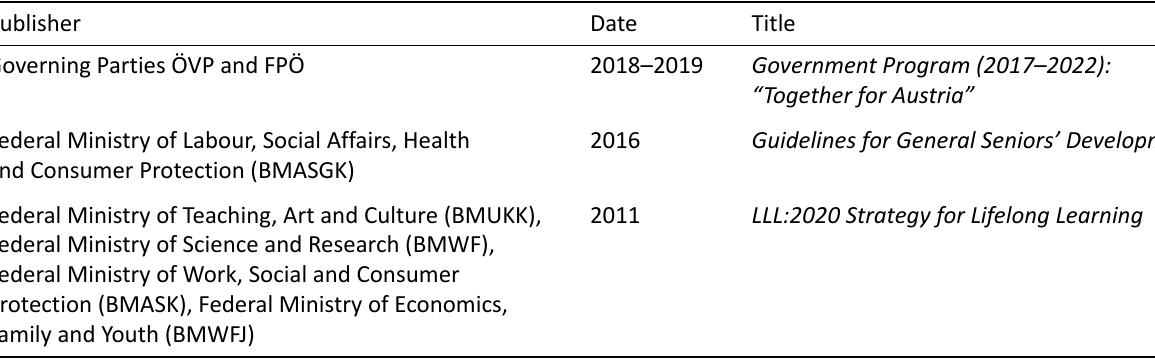
Table 1. Austrian policy papers used for the